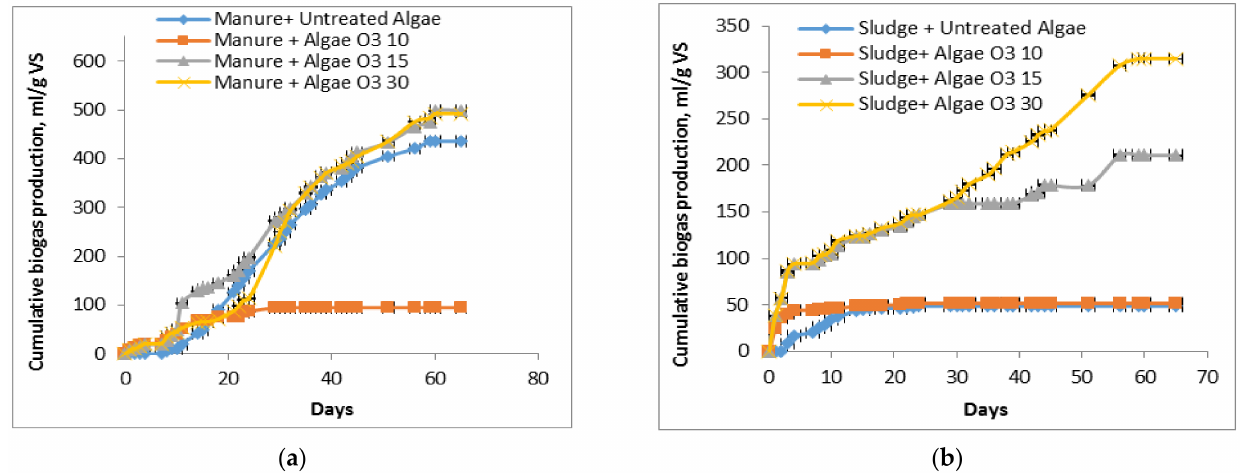
Figure 5. Average production of cumulative net biogas using ( a ) Manure and ( b )